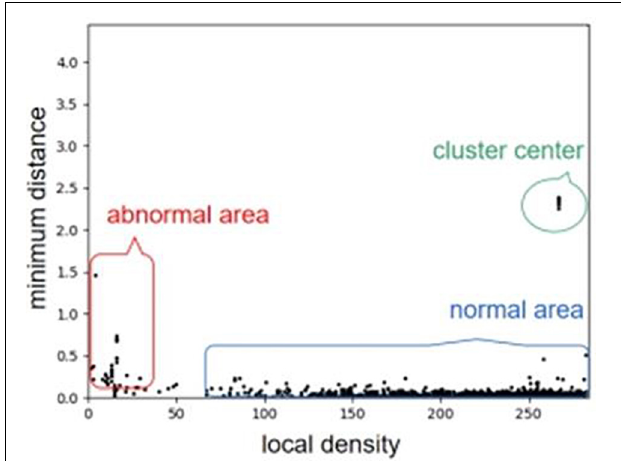
FIGURE 2 | An example of describing the distribution of a set of objects with respect to the values of the two features. We can note that the objects at the abnormal area (outliers) are near to the left and bottom side of the